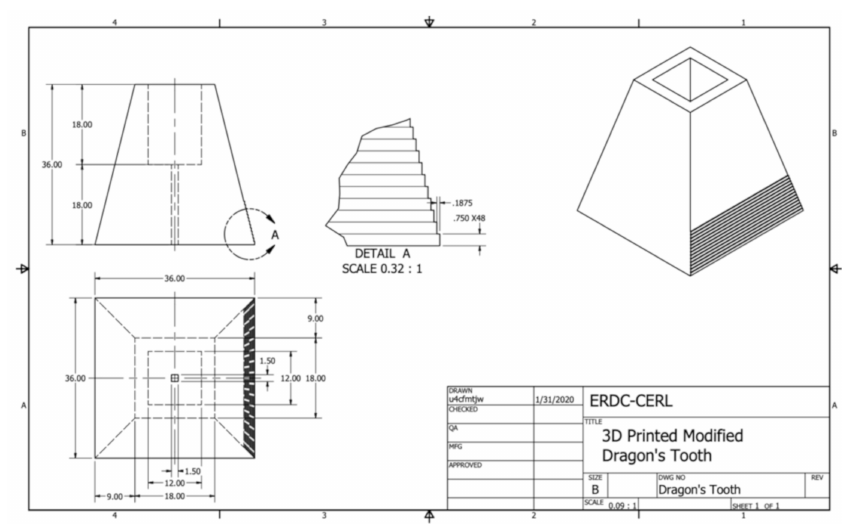
Figure 2. Design for Dragon’s